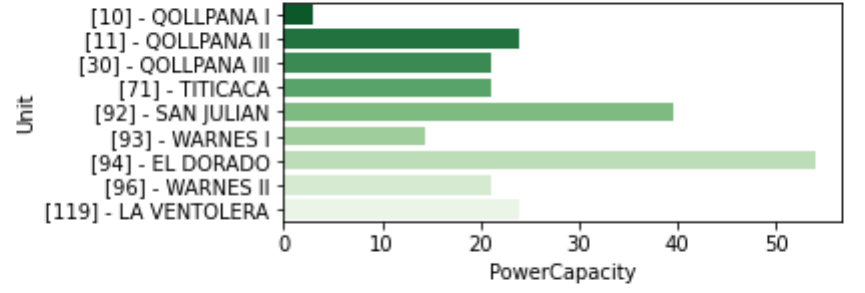
Figure 15. WIND ENERGY implemented and planned in the period 2020–2025 [35].